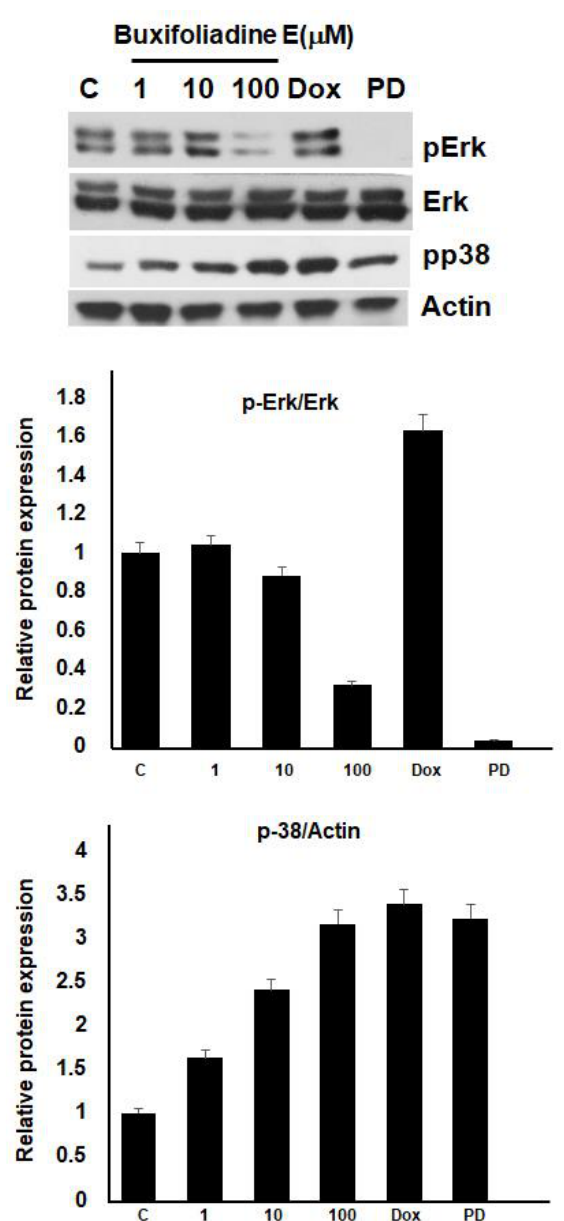
Figure 9. Buxifoliadine E induces apoptosis of HepG2 cells through the Erk pathway.